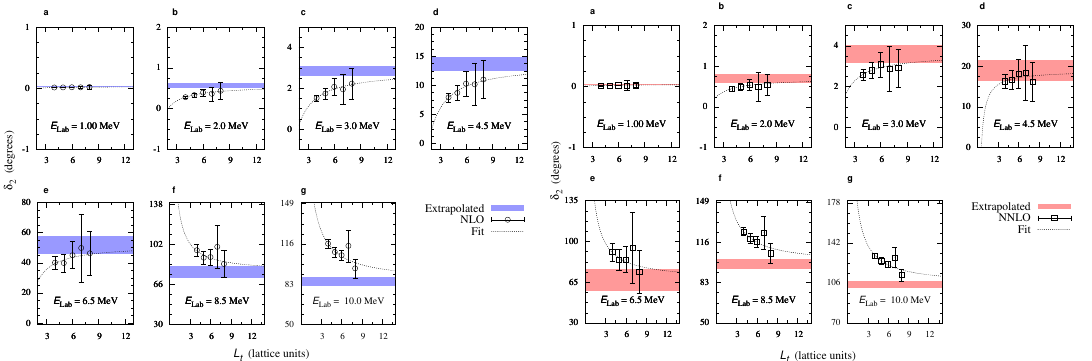
Figure 9 . NLO (left panel) and NNLO (right panel) results for the S-wave phase shift δ 0 versus L t for the lab energies E = 1 . 0 MeV, 2 . 0 MeV, 3 . 0 MeV, 4 . 5 MeV, 6 . 5 MeV, 8 . 5 MeV and 10 . 0 MeV, lab respectively. The theoretical errors indicate the 1 σ uncertainty due to the MC errors. The dotted lines are fits to the data and used to extrapolate to the L limit. The hatched areas represent t → ∞ the 1 σ error of the extrapolation.